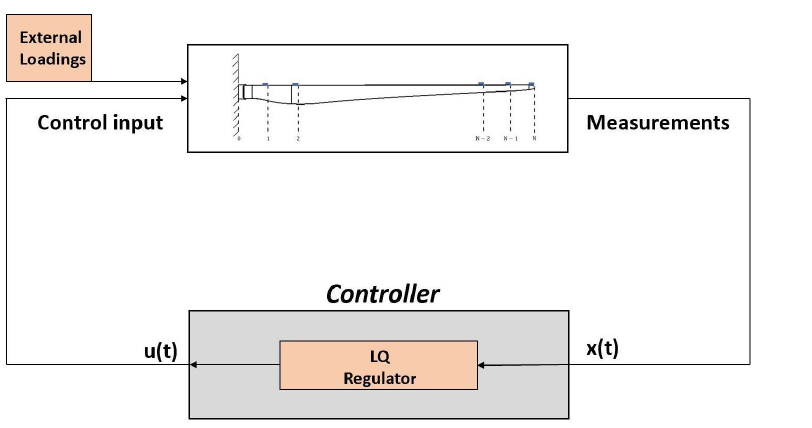
Figure 4. Block diagram for control.